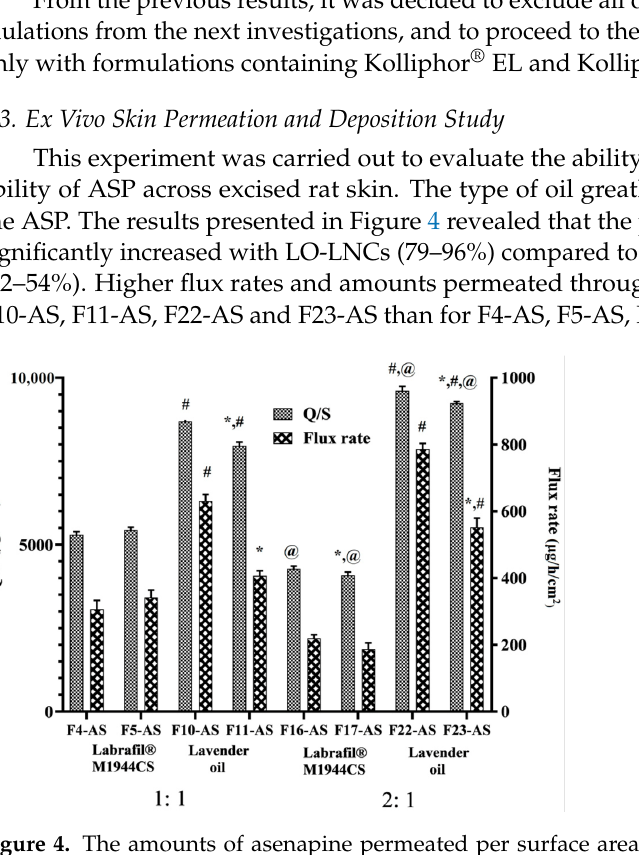
Figure 4. The amounts of asenapine permeated per surface area and flux rates of ASP from the different LNCs. All values are presented as the mean ± SD ( n = 6). * Significant difference in comparison to the formulation containing Kolliphor ® HS with the same oil type and ratio. # Significant difference in comparison to the formulation containing Labrafil ® M1944CS with the same surfactant type and oil ratio. @ Significant difference in comparison to the formulation with an oil:surfactant ratio of 1:1 with the same oil and surfactant